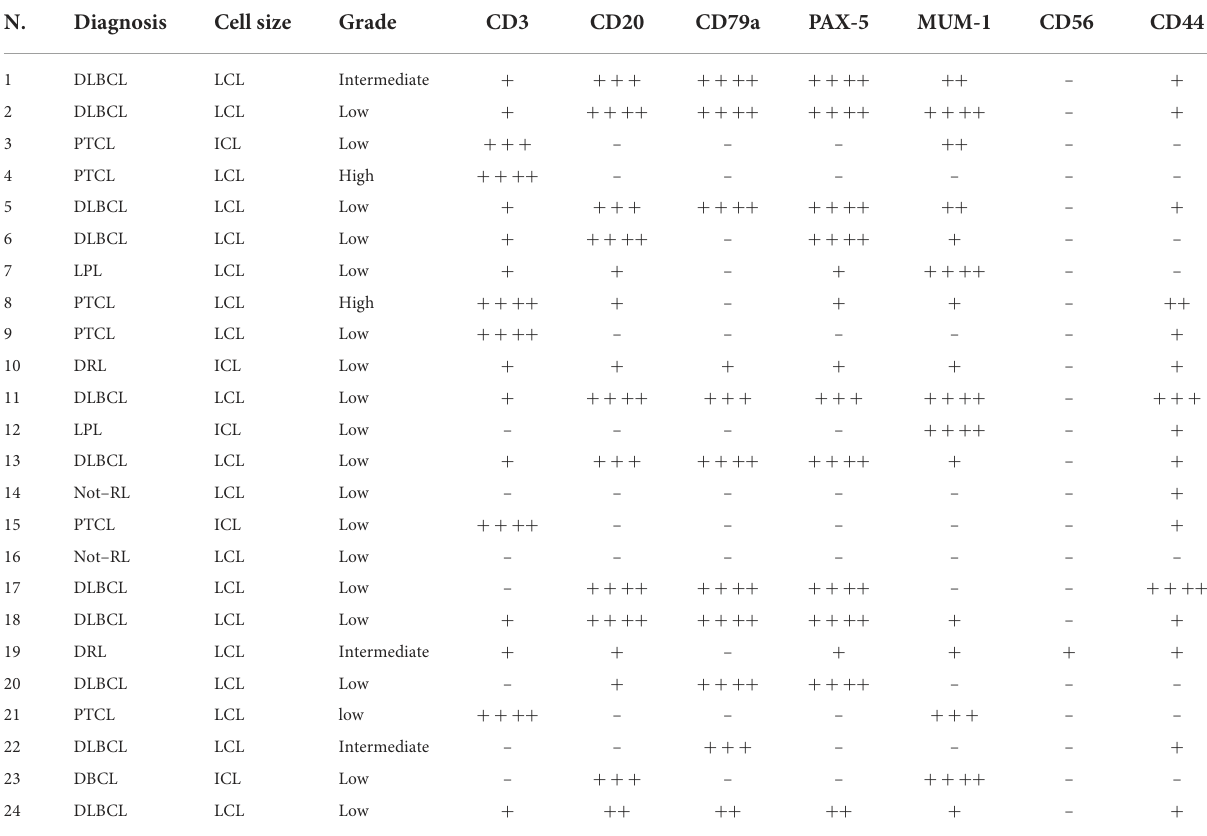
TABLE 3 Immunohistochemical findings and final diagnosis.